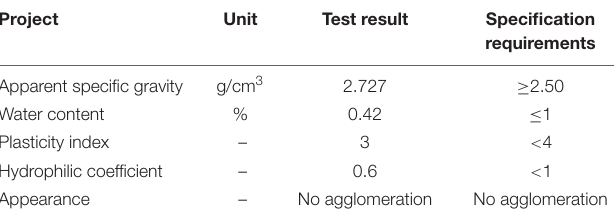
TABLE 4 | Mineral powder test